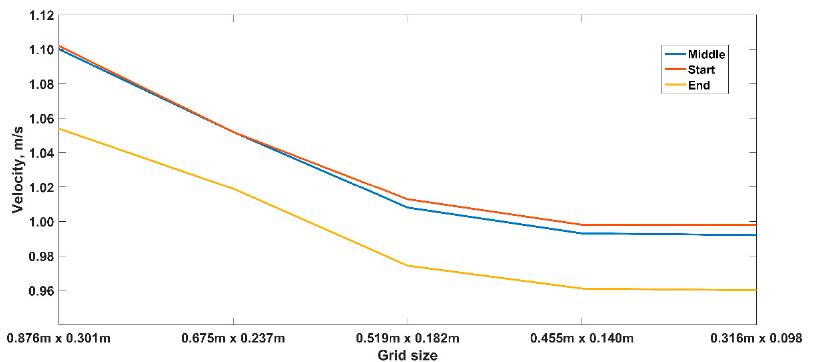
Figure 3. Results for the sensitivity analysis for the unstructured mesh size.